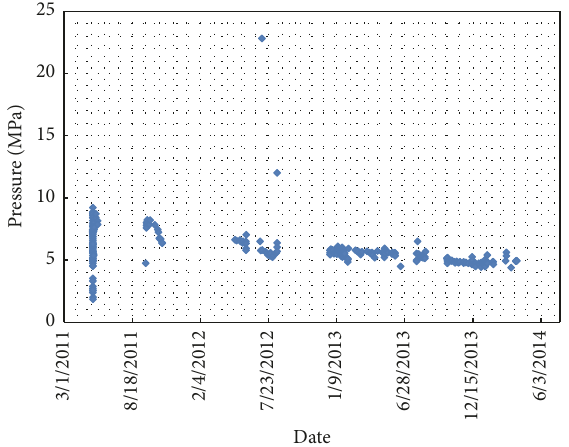
Figure 14: The monitoring records of wellhead injection